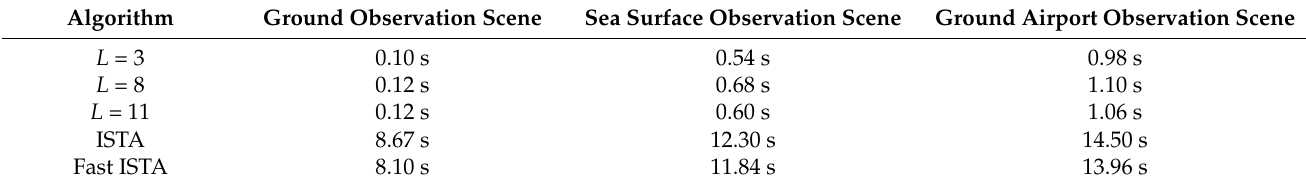
Table 3. Comparison of imaging